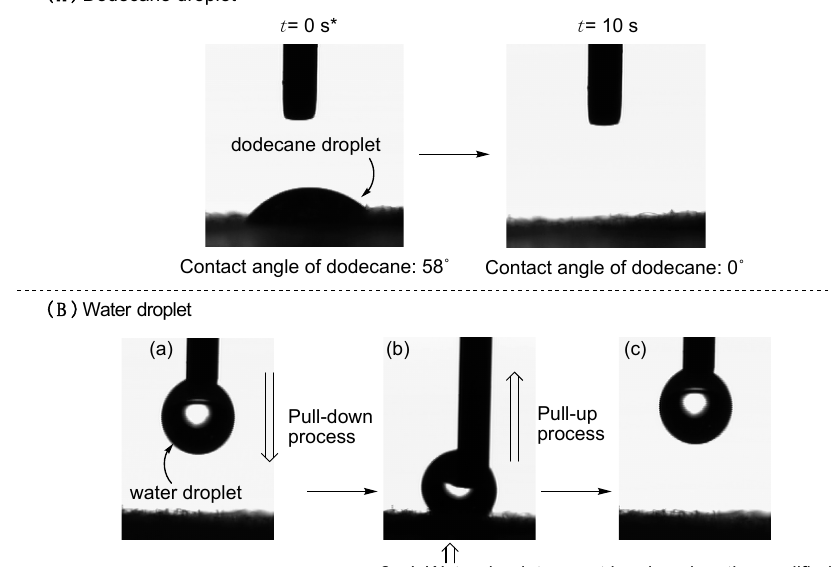
Figure 2. Photograph of the droplet of dodecane ( A ) and the droplet of water ( B ) on the modified cotton fabric surface with R F -VMSiO 2 /TAZ composites (Run 1 in Table 2): (*) “0 s” approximately corresponds to “a few seconds.” ( a ) Water drop on the needlepoint, ( b ) water drop on the fabric surface, ( c ) pull-up of needlepoint from the modified cotton fabric surface.